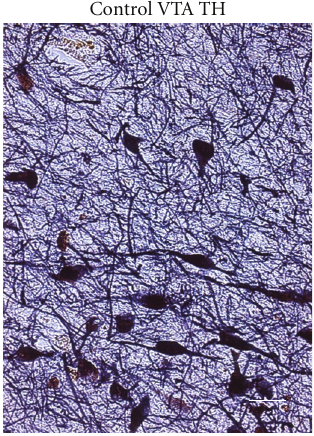
Figure 2: An image synthesized by AxioVision from a 50 µ m thick TH-stained section of the ventral tegmental area (VTA) of a 64- year-old male case of a legal autopsy. The VTA contains TH-ir neuronal cell bodies with diameter of 12–26 µ m. The size of these neurons is comparatively similar. The shape of TH-ir neuronal cell bodies is bipolar, fusiform, oval or triangular and is distinct from that of the case with disorganized type, schizophrenia (Figure 1(a)). Bar: 25 µ